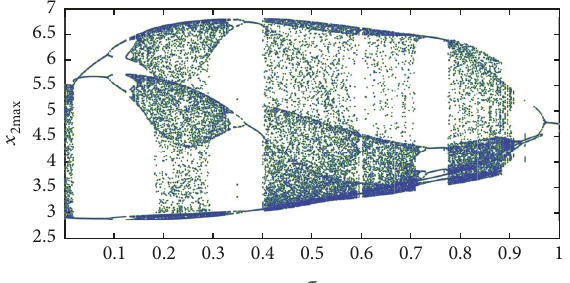
Figure 9: Bifurcation of the TDAHPS with time delay 𝜏 .